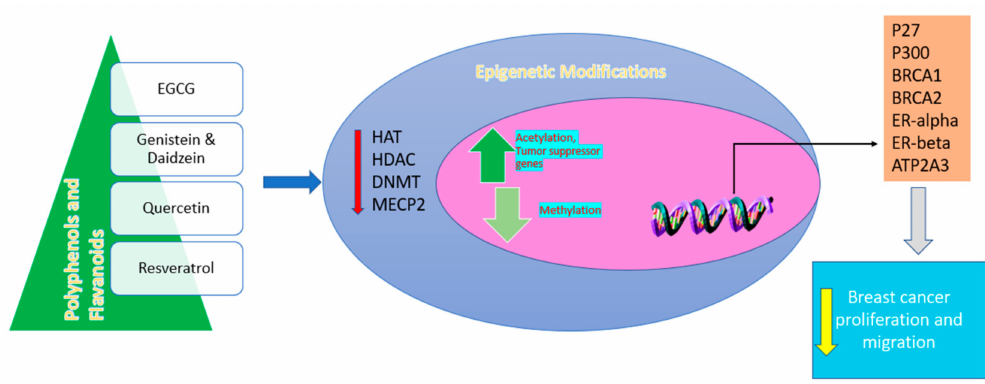
Figure 8. Diagram depicts epigenetic modification and tumor suppressor genes’ induction by the mechanism of flavonoids. Quercetin is a dietary flavonoid that inhibits the growth of tumors by hindering the protein tyrosine kinase (PTK). Diosmin exhibits antitumor activity in identical cancer cell lines. Tangeretin is a flavone that produces superior antitumor activity to other polyphenols against SK-MEL-5, SK-MEL-1, and B16F10 melanoma cell lines [94,95], PLC/PRF/5 cell lines, human lung DMS-14 cell lines, human hepatoma HepG2, Hep3B, and in breast MDA-MB-435 and MCF-7 cell lines. Flavone, including luteolin, appears to hinder cell growth and cell proliferation of various types of cancer which includes prostate cancer [96], hepatocellular carcinoma, pancreatic cancer cells, and non-small cell lung cancer cells. cervical cancer, human colorectal adenocarcinoma, prostate cancer cell, and breast